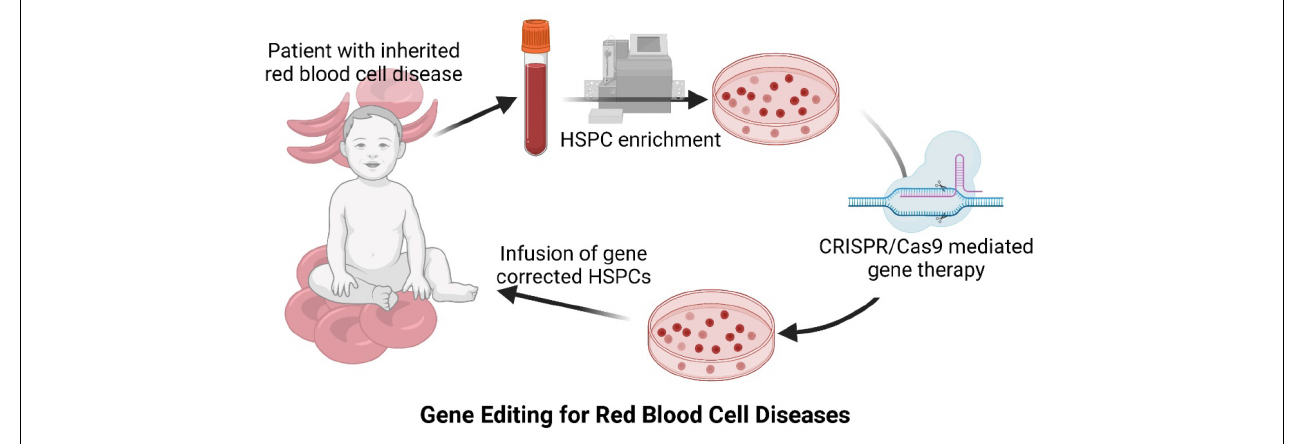
FIGURE 1 | Diagram of CRISPR/Cas9 mediated gene therapy approach for inherited red blood cell